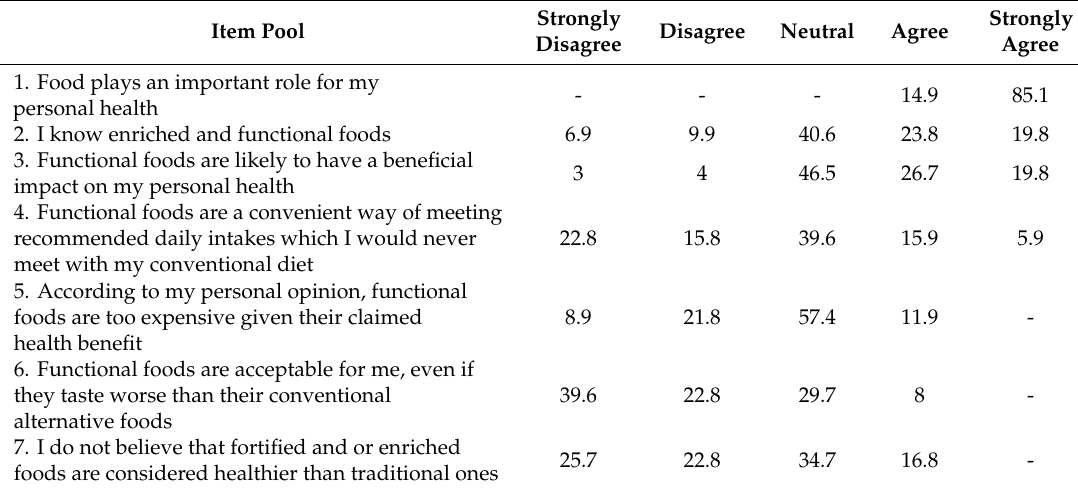
Table 3. Knowledge and acceptance of functional foods—frequency distributions of Likert-scaled variables (%, n =